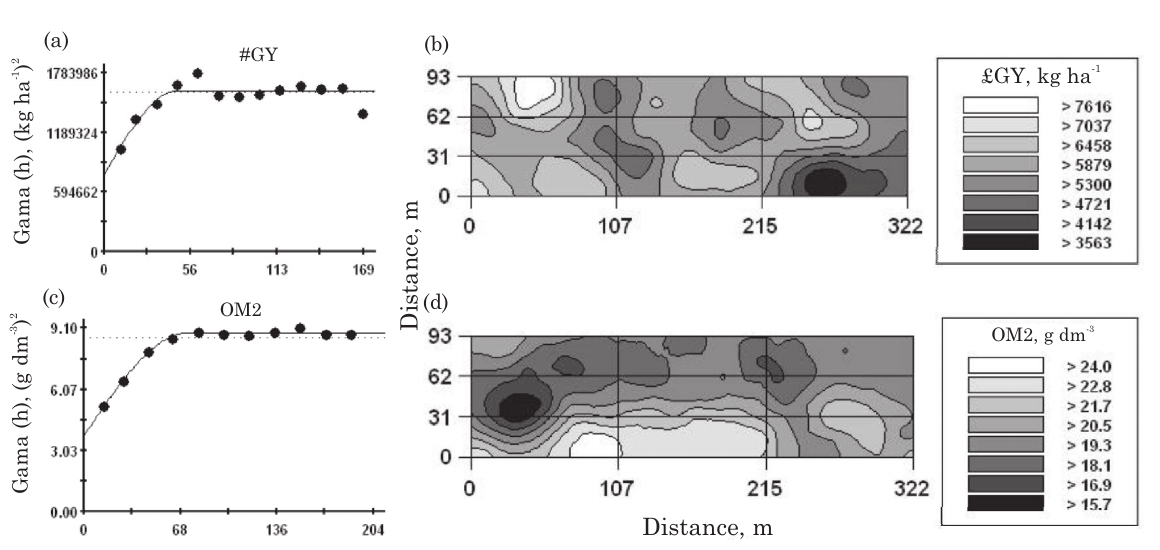
Figure 3. Simple semivariograms, cross-validation and kriging maps of rice grain yield and organic matter content of a Typic Acrustox under no-tillage.